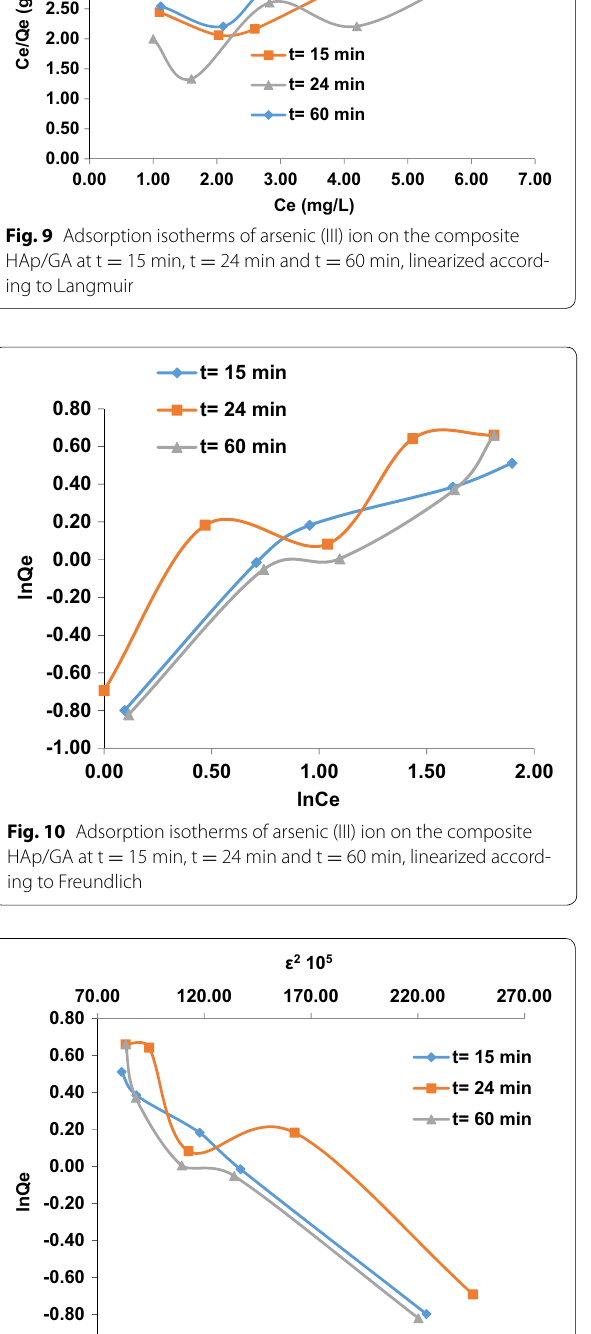
-1.00-0.80 Fig. 11 Adsorption isotherms of arsenic (III) ion on the composite HAp/GA at t 15 min, t 24 min and t 60 min, linearized accord- = = = ing to Dubinin–Radushkevich equations